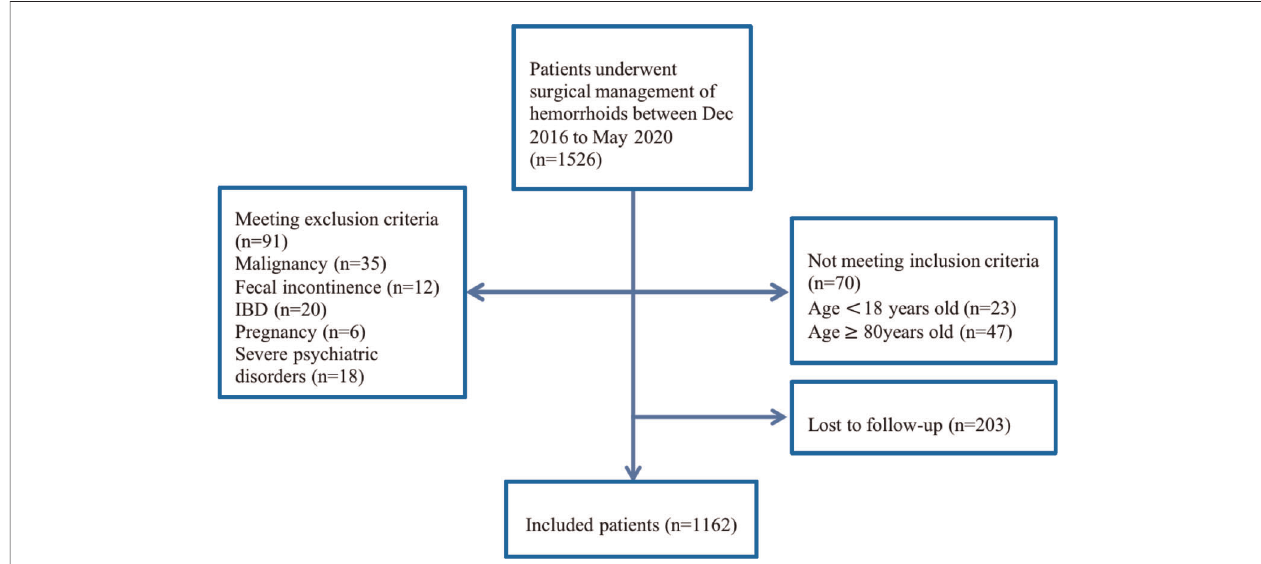
FIGURE 1 | Flow diagram study sample